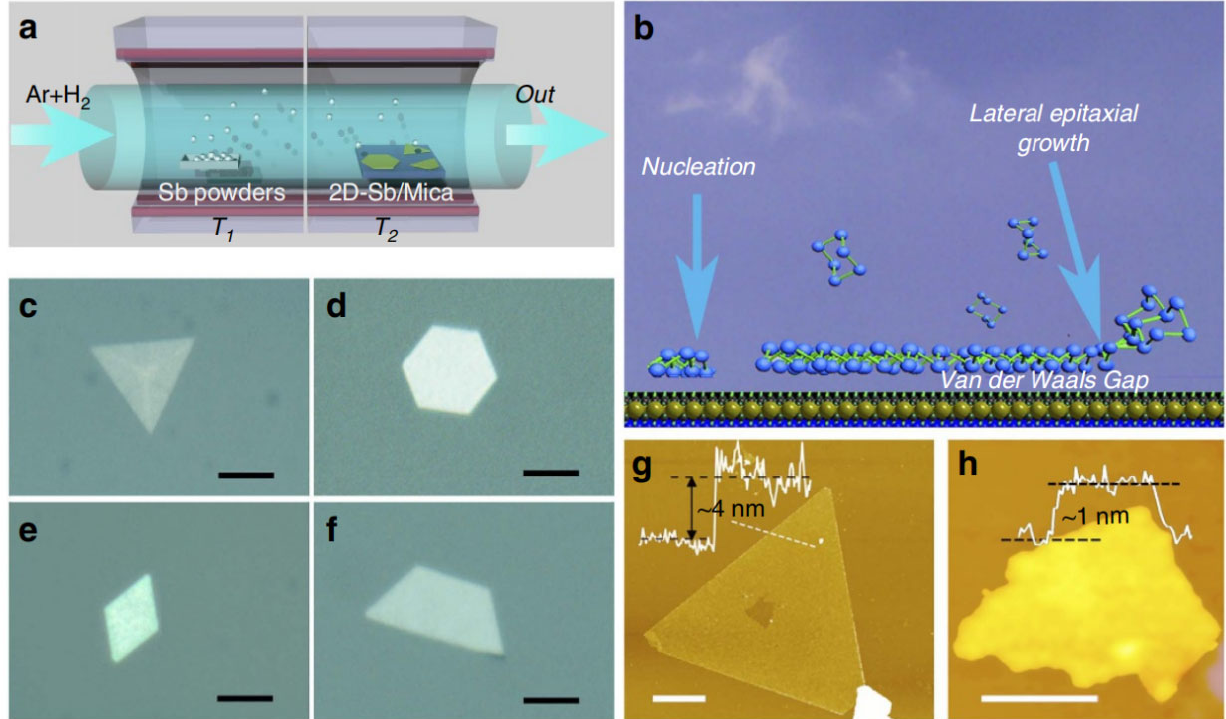
Figure 7. Synthesis of antimonene polygons on mica substrate by van der Waals epitaxy: ( a ) Schematic diagram of synthesis in tubular furnace; ( b ) schematic diagram of van der Waals epitaxial; ( c – f ) optical images of typical anti–monad polygons with triangular, hexagonal, rhombus and trapezoidal shapes, respectively. The scale is 5 µ m; ( g ) AFM images of typical triangular anti–monoene slices. The thickness is 4 nm. The scale is 1 mm; ( h ) atomic force microscope image of microantimonene sheet. The thickness is approximately 1 nm. The scale is 50 nm. Reprinted with permission from Ref. [9]. Copyright 2016, Springer Nature.